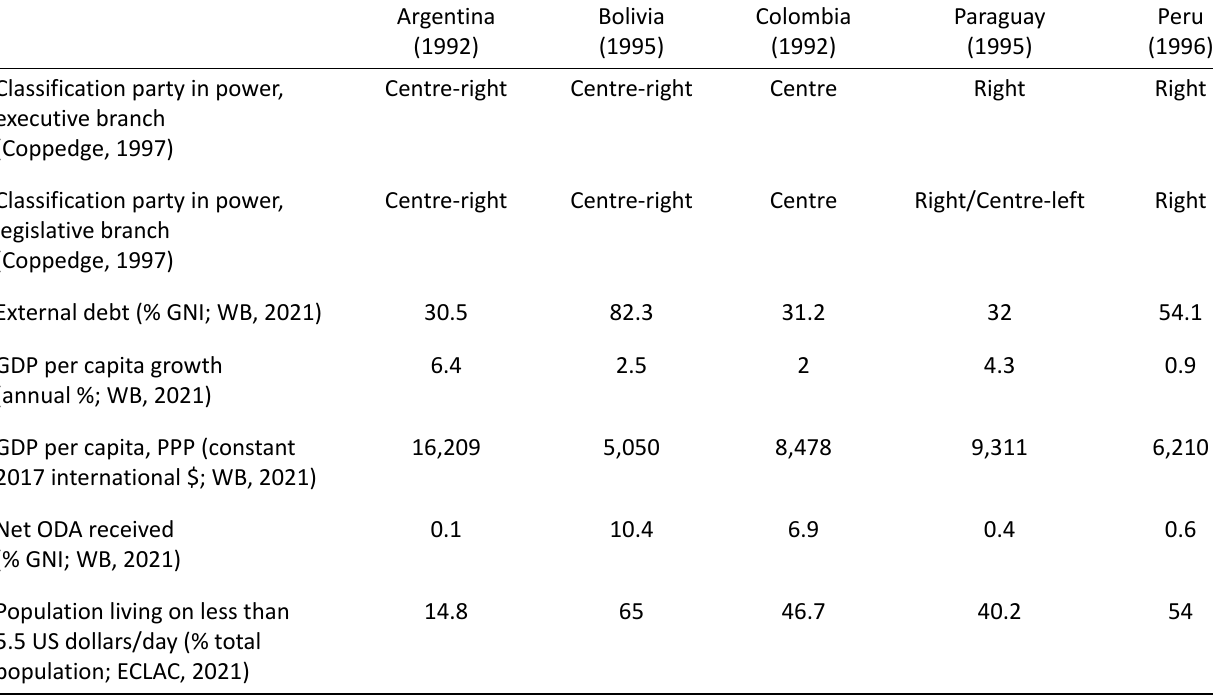
Table 1. Domestic conditions prior to reform, by country (reference year in